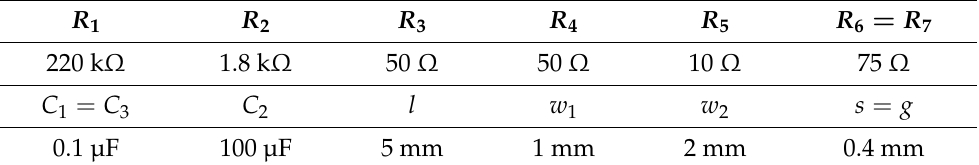
Table 1. Dimensions of the sensor with component